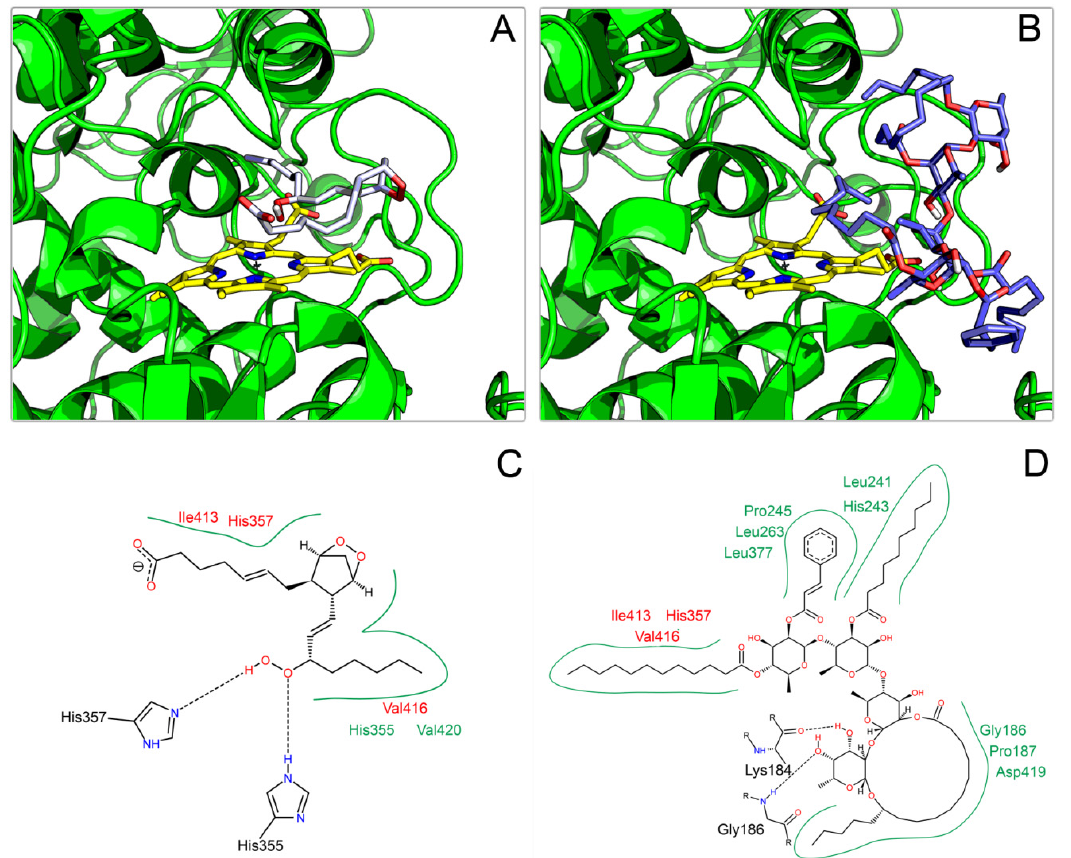
Figure 4. Complexes obtained for PGG ( A , C ) and ipomotaoside 1 ( B , D ) with COX-1 as 2 derived from docking calculations. Heme group is highlighted in yellow. 2D images, generated with the PoseView server [17], present only interactions between the ligand and amino acid residues. Common amino acid residues between PGG -COX-1 are indicated in 2